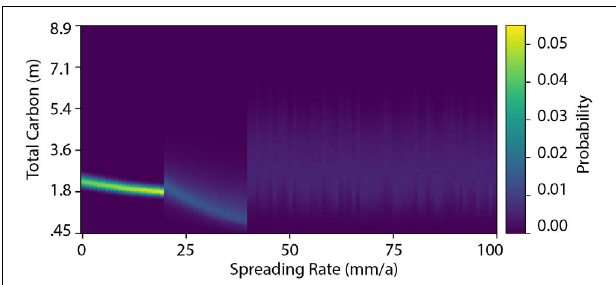
FIGURE 6 | Conditional probability of the value of total carbon sequestered in ocean crust as a function of the spreading rate of the ridge at which it formed, with the ranges determined by all the variation in parameters listed in Table 1 .